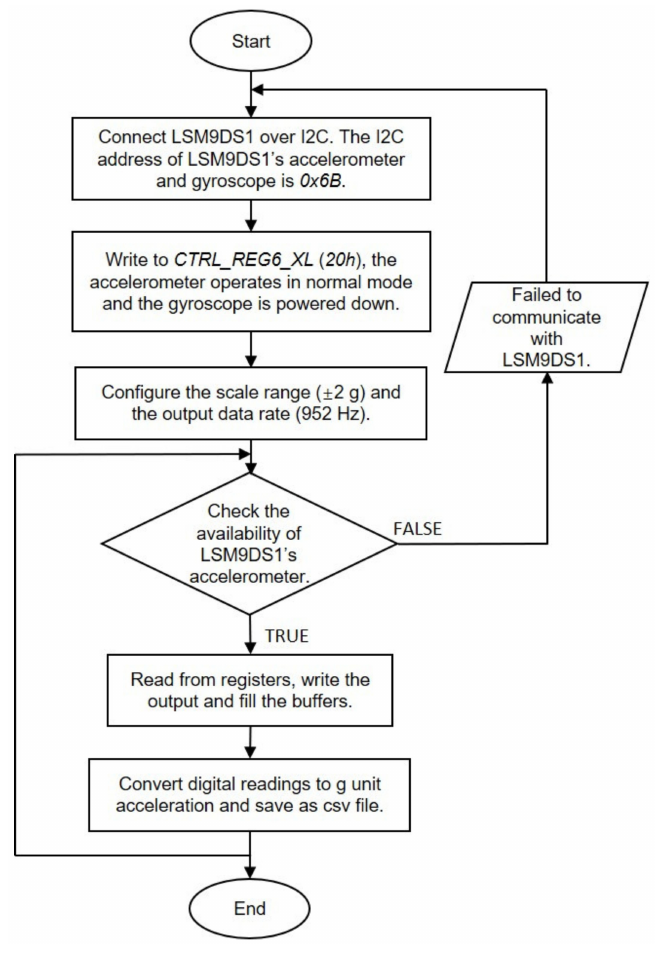
Figure 5. Flowchart of acceleration data acquisition and